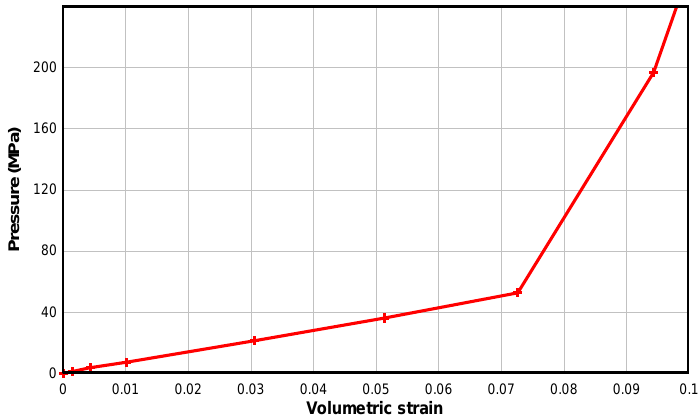
Figure 5. Equation of state (EOS) for AC with f c = 4.6 MPa.